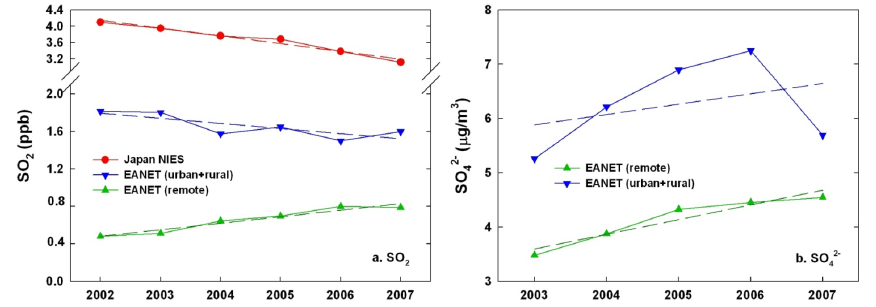
Fig. 10. Inter-annual variation of SO 2 − and SO 2 average concentrations at Japan NIES sites and EANET sites. Dashed lines represent the 4 linear tendencies.